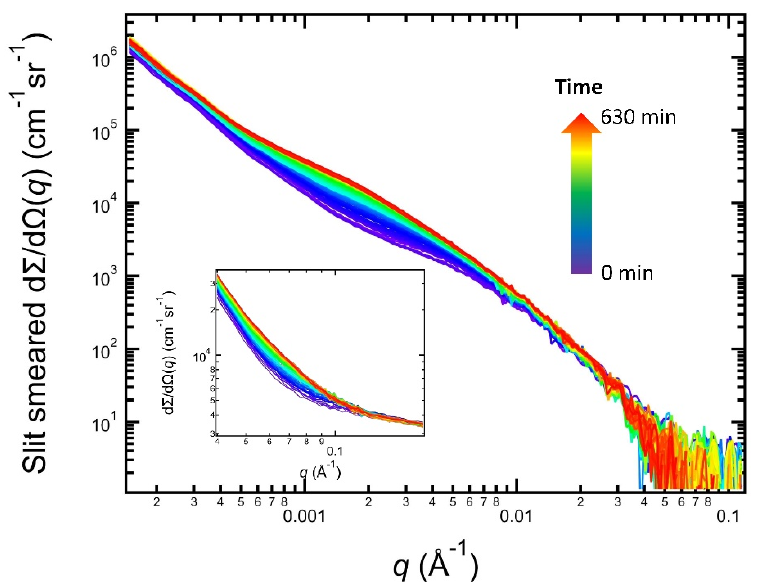
Figure 6. In situ SAXS data of AM IN625 acquired during isothermal heat treatment at 700 °C for 10.5 h. The main plot and the inset show the USAXS and SAXS data, respectively. The acquisition time is color-coded following the time arrow. The USAXS intensity is slit-smeared.